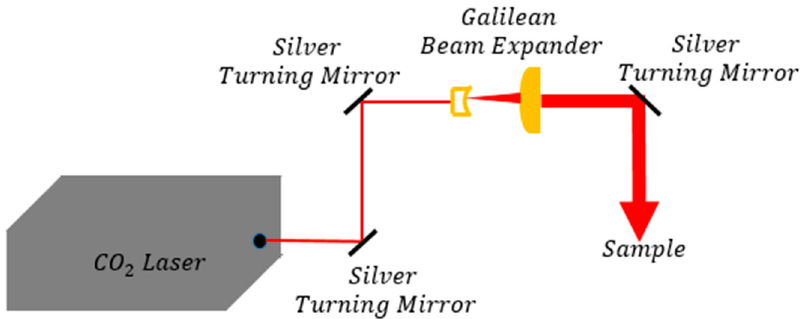
Figure 1. CO 2 laser beam path.